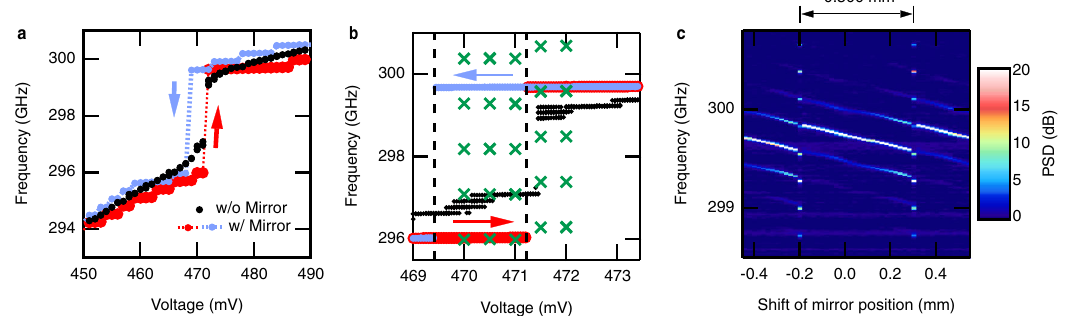
Fig. 3 Conditions of passive mode-locking. a Frequency-voltage curve measured without mirror (black dots), with mirror and up-swept voltage (red dots), and with mirror and down-swept voltage (blue dots). Signi fi cant hysteresis on the sweep direction was not observed in the case of no mirror. b Frequency- voltage curve measured around the frequency jump point (markers are the same as in a ). The green crosses show the frequencies of the comb peaks observed when the mirror was swept at each bias voltage. c THz spectrum observed when the mirror was swept with a bias voltage of 471 mV. The horizontal axis shows the shift of the mirror position 4 z M . The sweep direction was the one in which 4 z M decreases. These fi gures were measured with the maximum feedback amplitude in our setup. The frequency resolution was 11 MHz. The data points in panels a and b were extracted from the series of spectra obtained during the voltage sweep and are the frequency points that had a PSD larger than the noise level by